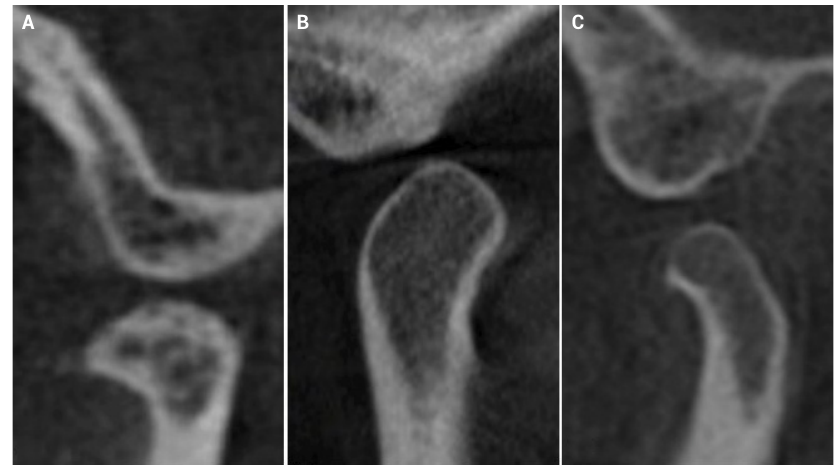
Figure 2. Examples of condylar excursion estimates. (A) hypoexcursion; (B) normal excursion; (C) hyperexcursion.